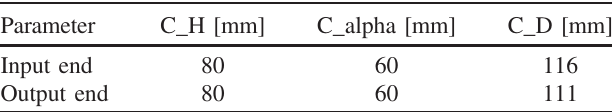
undercuts.TABLE TABLE IV. Main rf parameters of the HIAF FIG. 20. Sketch map of the undercut. FIG. 21. Field flatness with and without